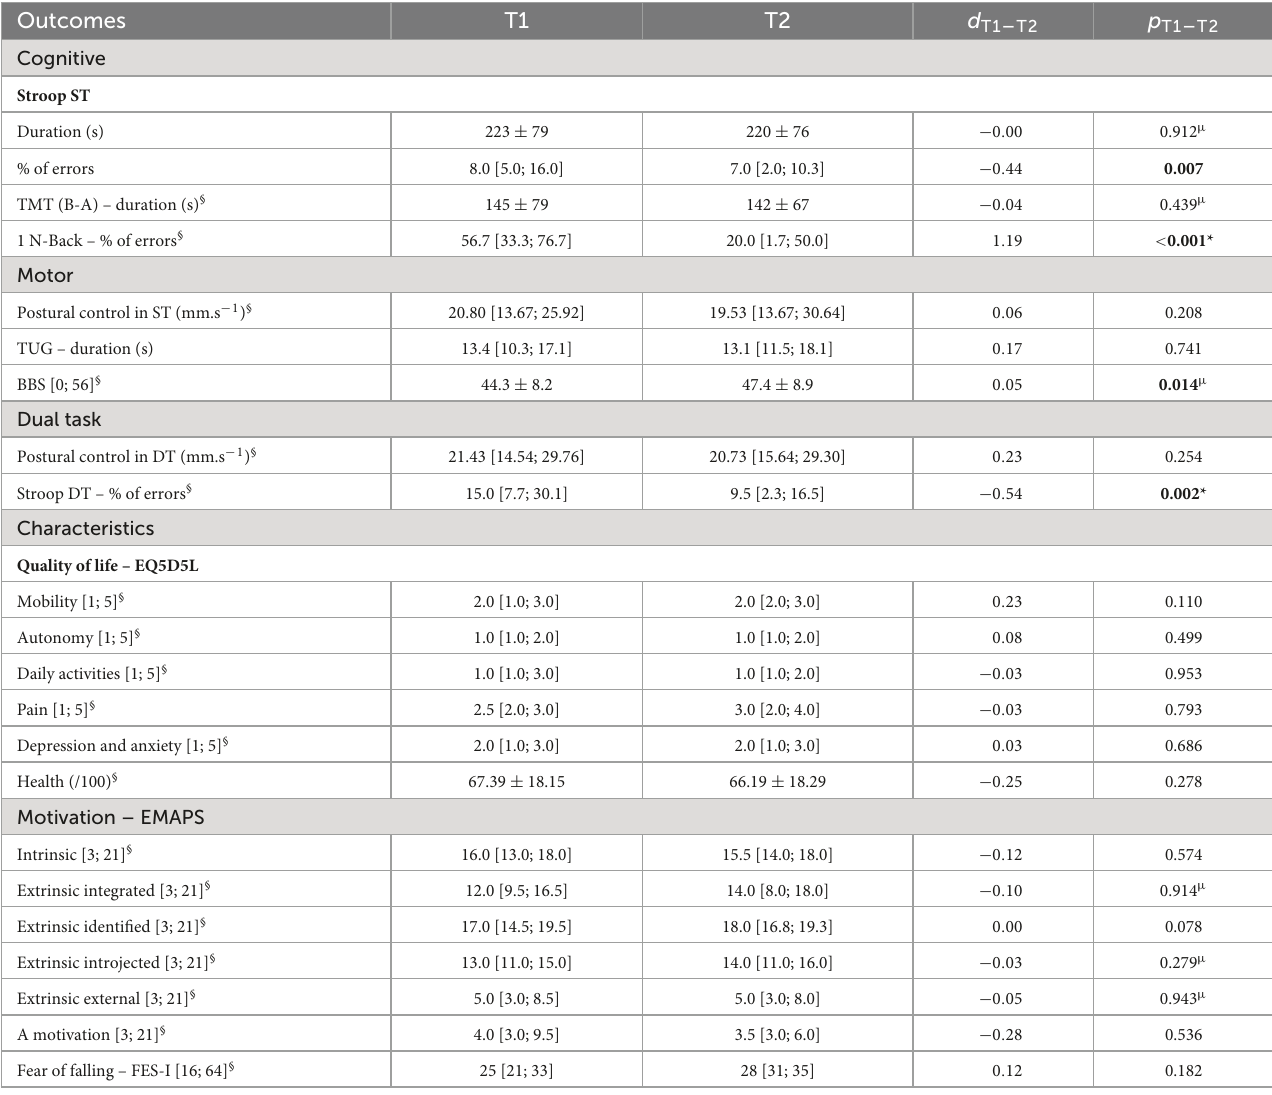
TABLE 1 Difference before (T1) and after (T2) 12 weeks of exergaming in 34 participants.